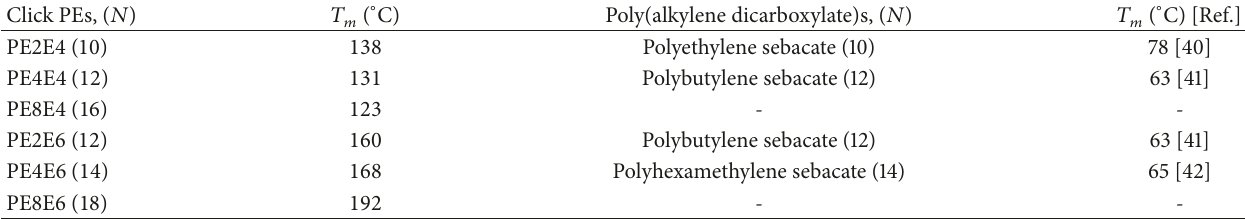
Table 13: Melting temperatures ( 𝑇 푚 ) of the click PEs versus 𝑇 푚 of the regular PEs.